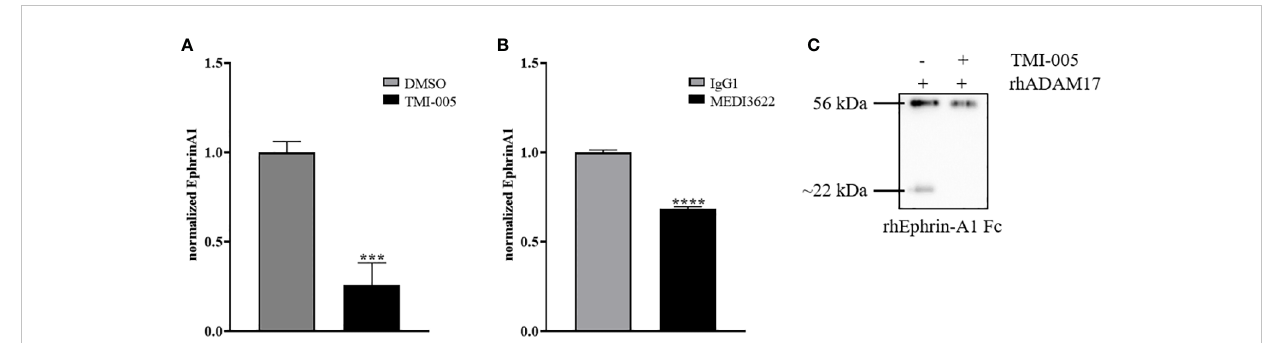
FIGURE 5 Ephrin-A1 cleavage is mediated by ADAM17. Cellular supernatants derived from NCI-H358 cells were analyzed for cleaved ephrin-A1 24 hours after (A) TMI-005 (25µM) or (B) MEDI3622 (200nM) treatment by ELISA. (C) rhEphrin-A1 was incubated with rhADAM17 for acellular cleavage. TMI-005 inhibited ADAM17-mediated ephrin-A1 cleavage. Bar graphs represent Ephrin-A1 concentration normalized to total cellular protein amount ± SEM from three independent biological replicates. ***, P < 0.001; ****, P <